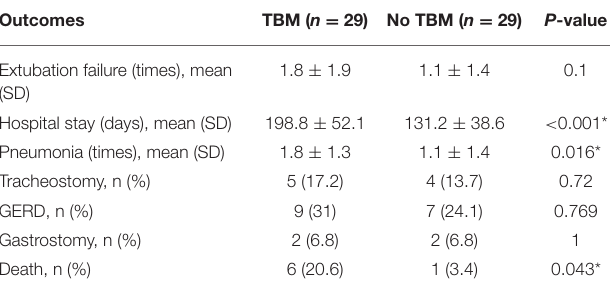
frequent sputum suction and manual ventilation, combined with TABLE 3 | Comparisons of in-hospital morbidity and mortality between the infants with and without TBM.